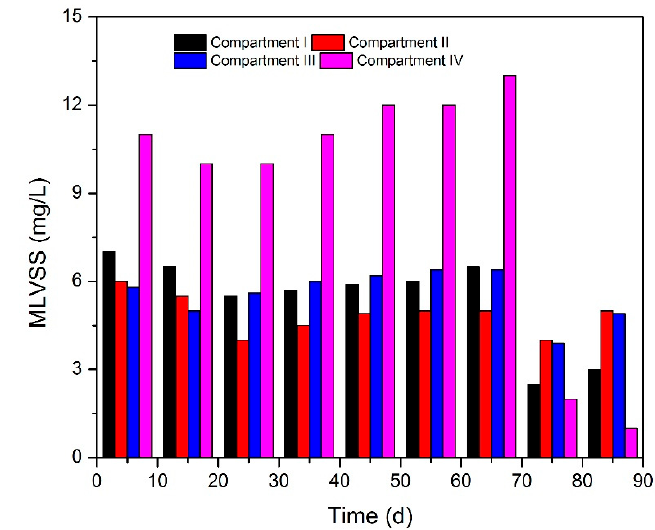
Figure 2. Biomass concentration trend over time in each compartment of ABR.